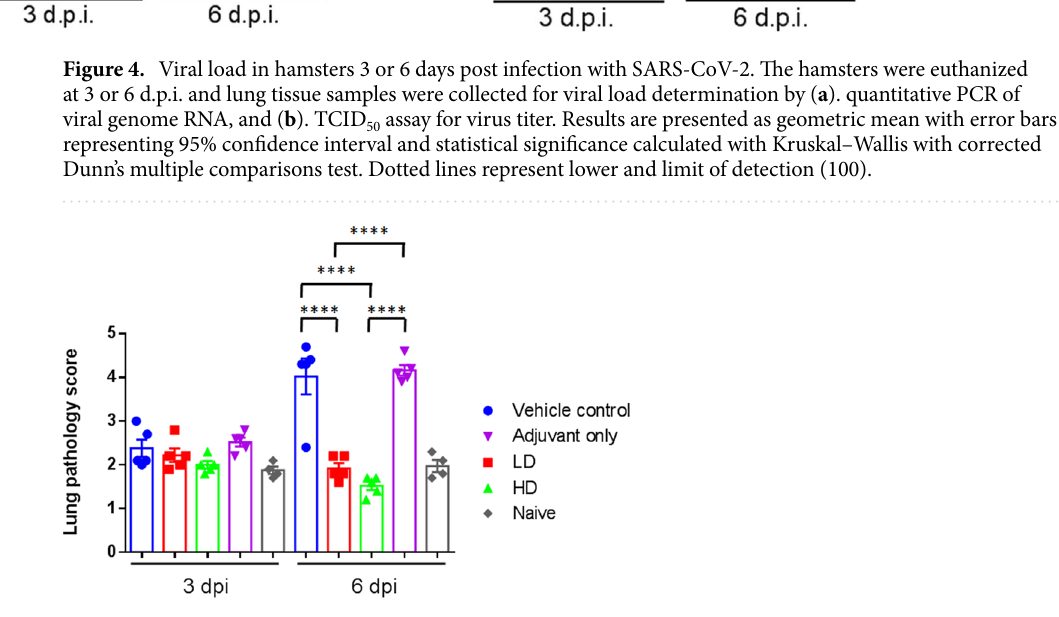
Figure 5. Lung pathology scoring in hamsters 3 or 6 days post infection with SARS-CoV-2 . The hamsters were euthanized at 3 or 6 d.p.i. and lung tissue samples were collected for sectioning and staining. The histopathology sections were scored as outlined in the methods and the results tabulated. Results are presented as mean of lung pathology scores with error bars representing standard error and statistical significance calculated with one-way ANOVA with Tukey’s multiple comparisons